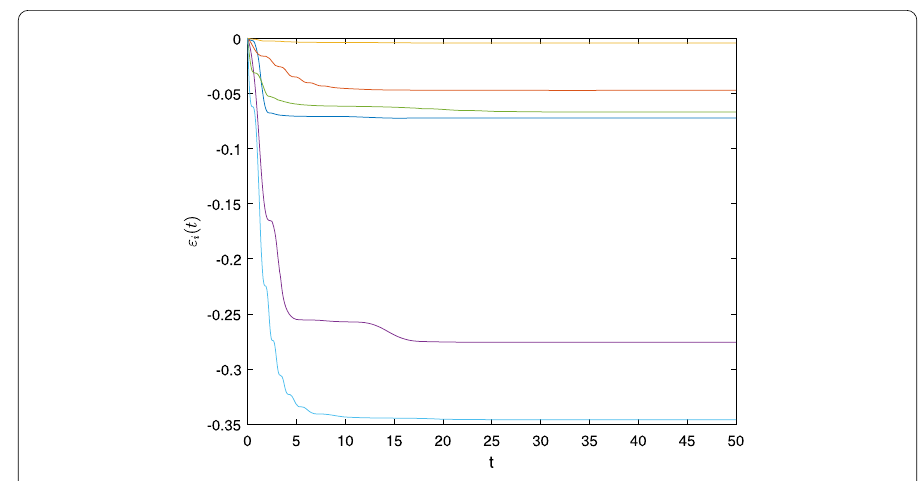
Figure 13 The temporal evolution of the adaptive control gain ε i ( t ), i = 1,2, ...